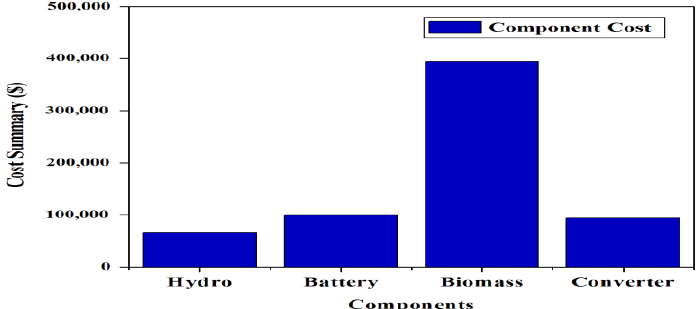
Figure 13. Total component cost breakdown for case I (Ba/Bi/H).